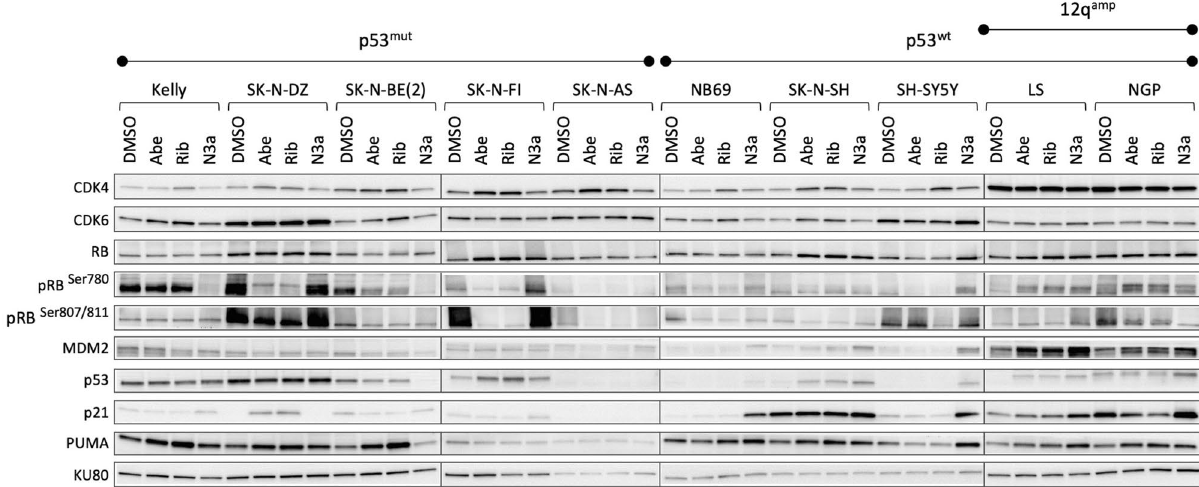
Figure 6. Effect on proteins of the CDK4 and MDM2 pathway after CDK4/6 or MDM2 inhibition. The cells were treated with abemaciclib (Abe), ribociclib (Rib), and Nutlin-3a (N3a) at IC50 values for 72 h before protein extraction. This figure is a representation of the protein expression using different blots. The blots are delineated to clarify that belong to different gels or to different parts of the same gel. Each blot was normalized using KU80 as control. Exposure time for each protein analysis was the same for all cell